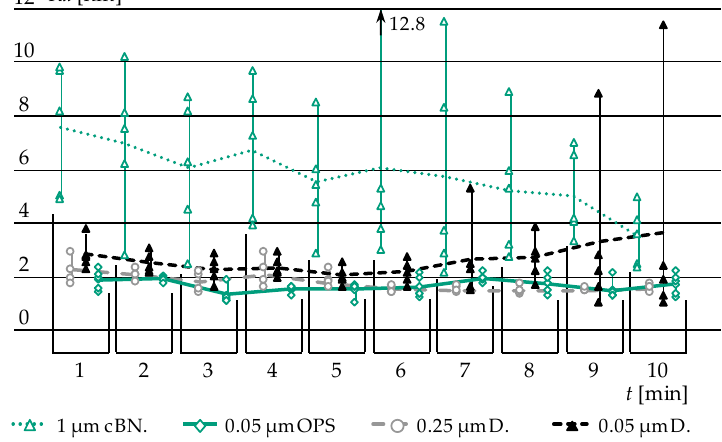
Figure 9. Comparison of different polishing abrasives and their performance in terms of decreasing surface roughness.